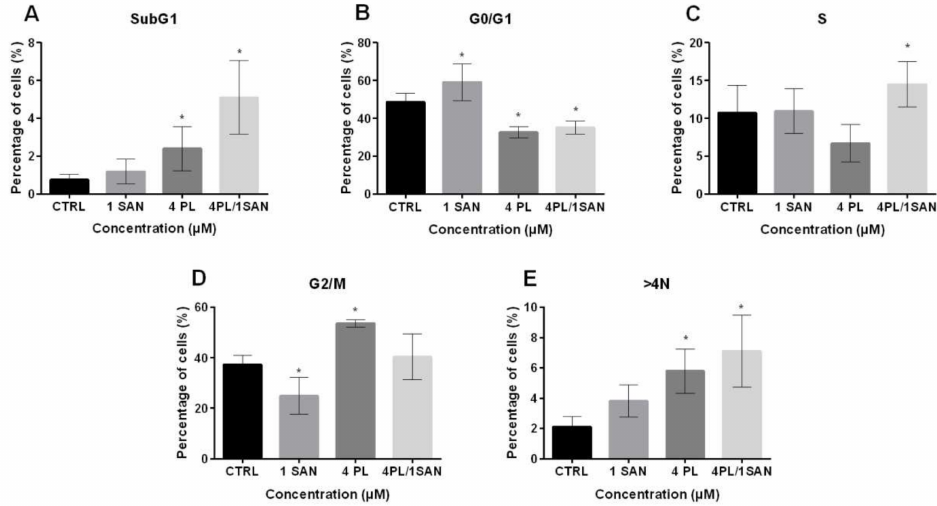
Figure 5. The e ff ects of piperlongumine (PL) and sanguinarine (SAN) individually and in a combined treatment on the cell cycle of A549 cells. The percentage of cells in SubG1 phases ( A ), G0 / G1 ( B ), S ( C ), G2 / M ( D ) and > 4N ( E ). Data represent the mean values ± SD obtained from 6 independent replicates ( n = 6). Statistically significant di ff erences in comparison to untreated cells were marked as * ( p < 0.05; Kruskal-Wallis with Dunn’s post hoc